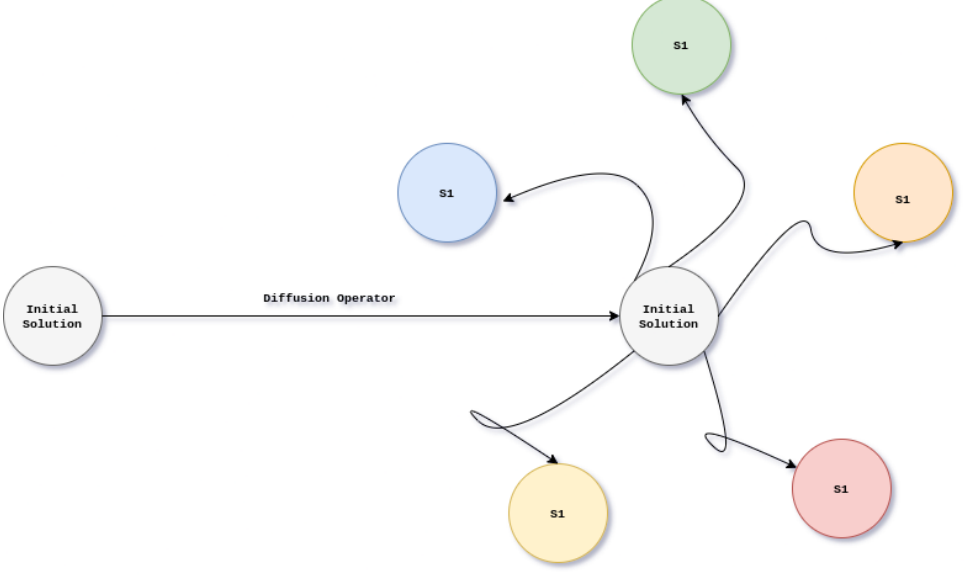
Figure 2. Diffusion